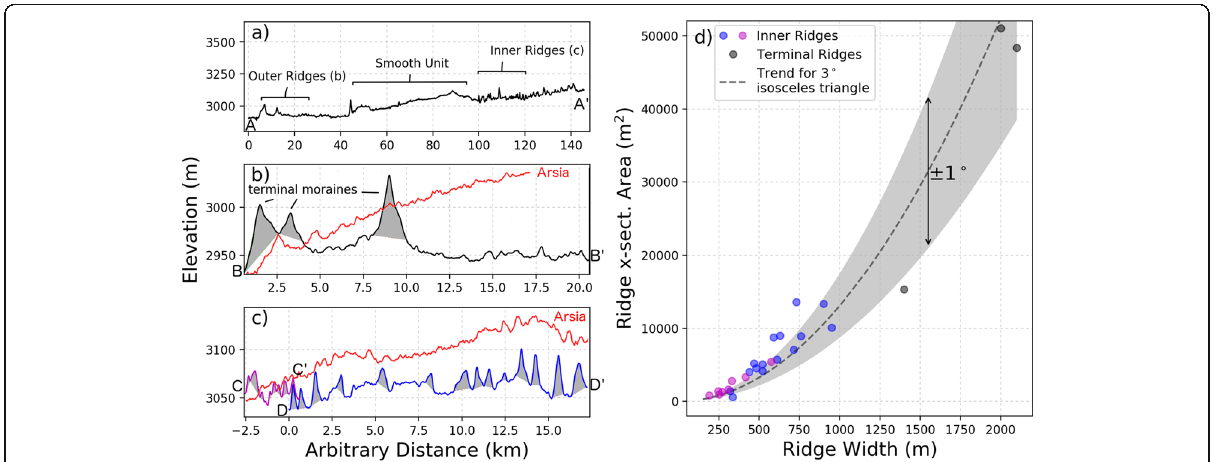
Fig. 4 Ridge topographic profiles and cross-sectional areas measured from the CTX stereo DEM shown in Fig. 2. a This section of the FSD consists of outer ridge, smooth, and inner ridge units which rest on a regional slope of 0.1 ° . We, in agreement with prior work, interpret the outer ridges as terminal moraines ( b ) which are much larger than the interior ridges ( c ). The red lines in ( b ) and ( c ) indicate that ridges at Arsia are smaller and more closely spaced than at Pavonis (black, magenta, and blue lines). d The increase in cross-sectional area (y-axis) with ridge width (x-axis) generally follows the trend given by an isosceles triangle with flank slopes of 3 ° (dashed line) although the smaller, inner ridges tend to have steeper slopes, but well below the angle of